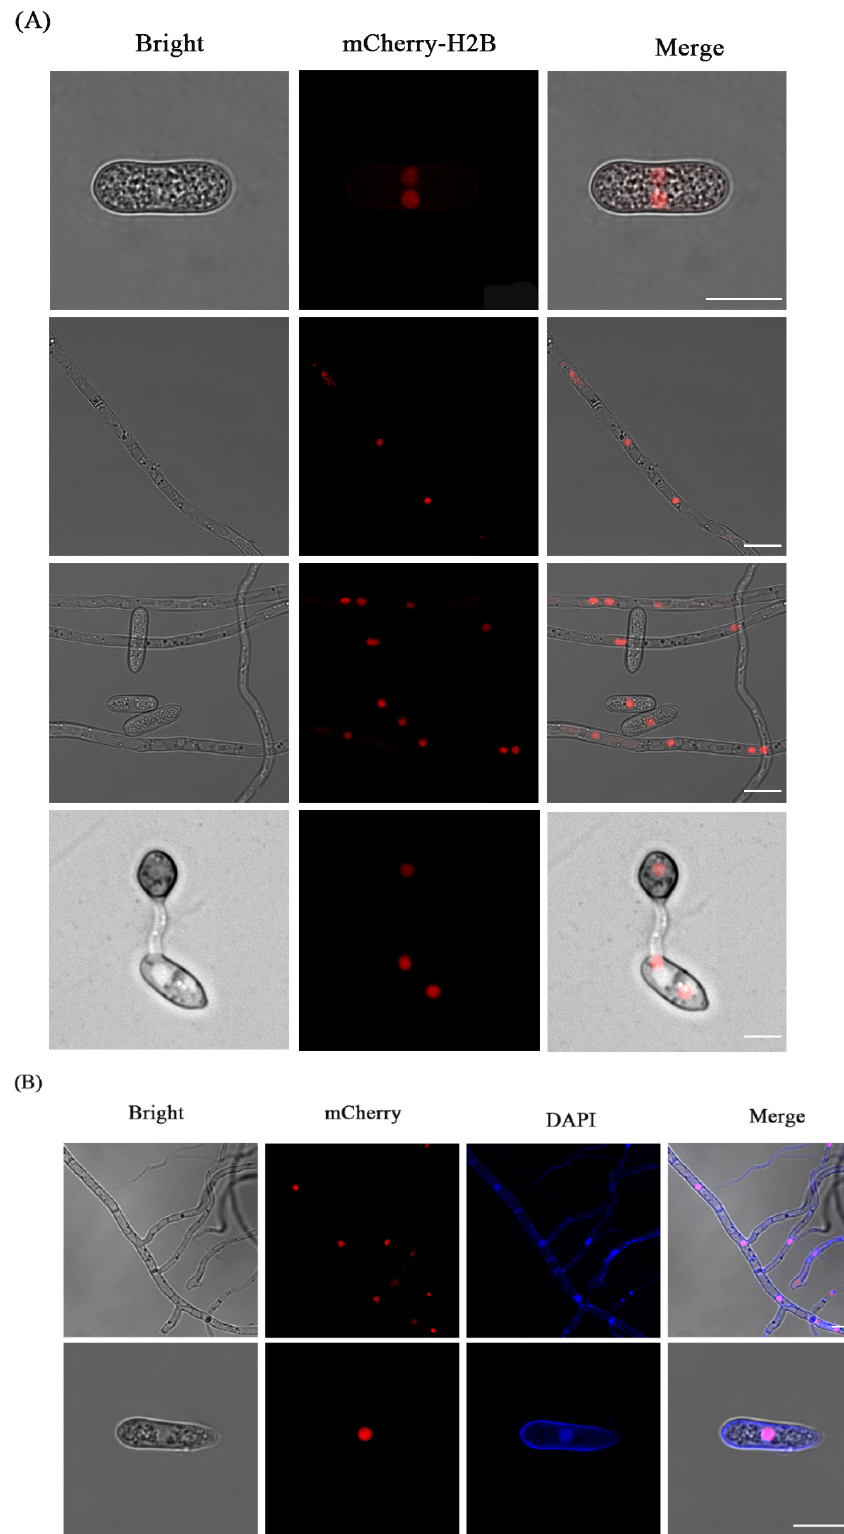
Figure 5. Fluorescent labeling of the nuclei in C. aenigma with mCherry-H2B. Bars = 10 µm. ( A ) The mCherry-H2B transformants were detected under a confocal microscope to check the labeled nuclei in spores, hyphae, and appressoria; ( B ) The co-localization of mCherry-H2B and DAPI in the nuclei of the